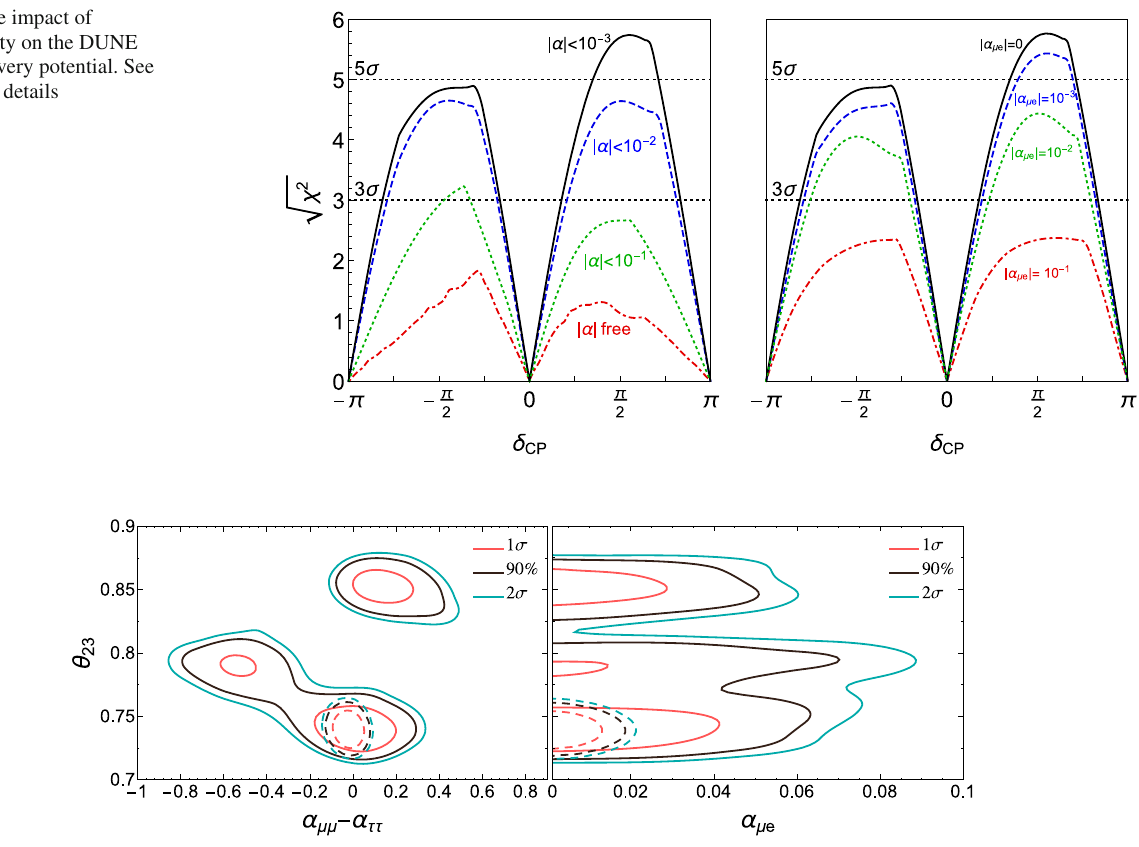
Fig. 6 Expected frequentist allowed regions at the 1 σ , 90% and 2 σ CL for DUNE. All new physics parameters are assumed to be zero so as to obtain the expected non-unitarity sensitivities. A value θ 23 =